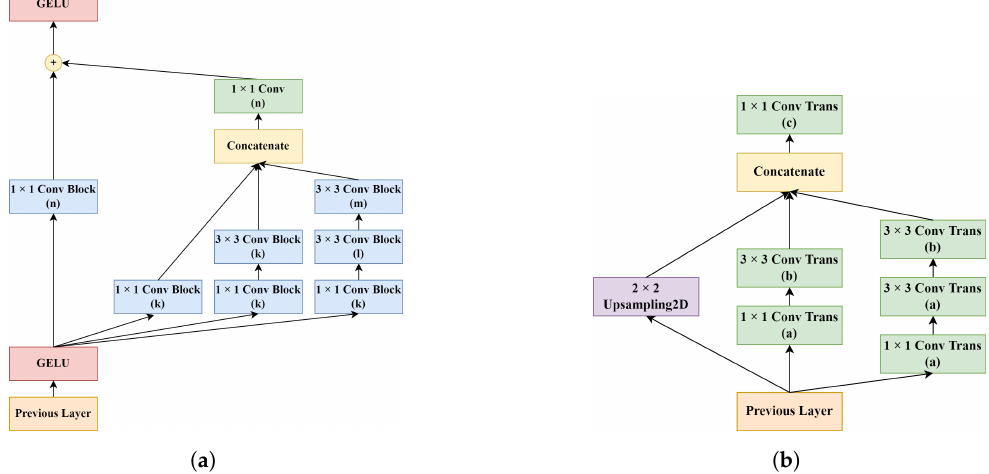
Figure 6. The flow diagram of the modules used in the bottleneck and decoder paths of the RIU-Net: ( a ) Module D, and ( b ) Upsampling